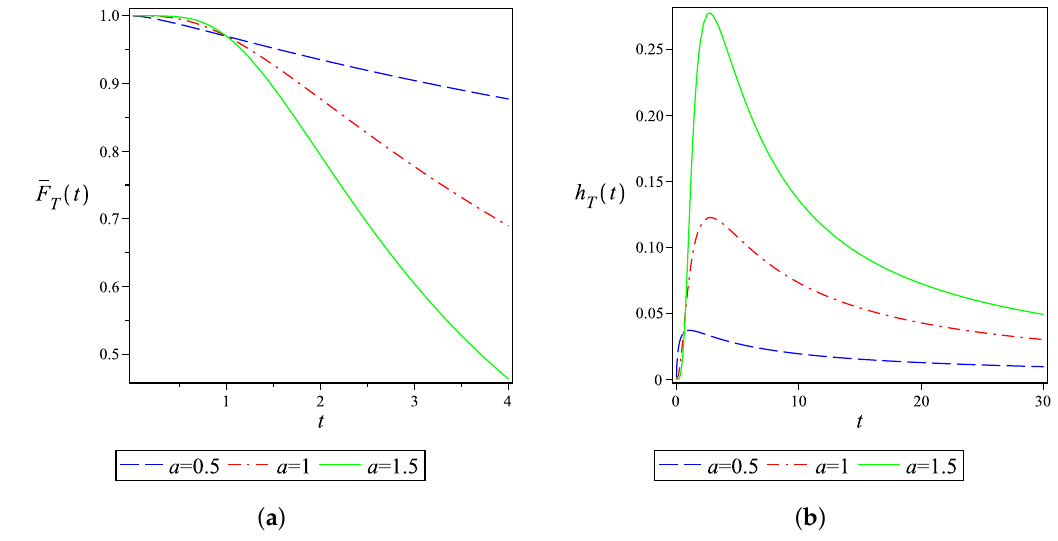
Figure 2. The plots of ( a ) the reliability function; ( b ) the hazard rate of network lifetime when the terminals set is T = V